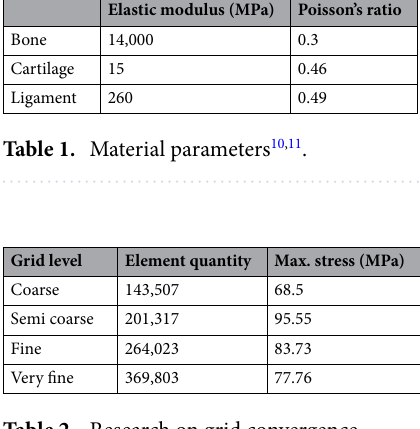
Table 2. Research on grid